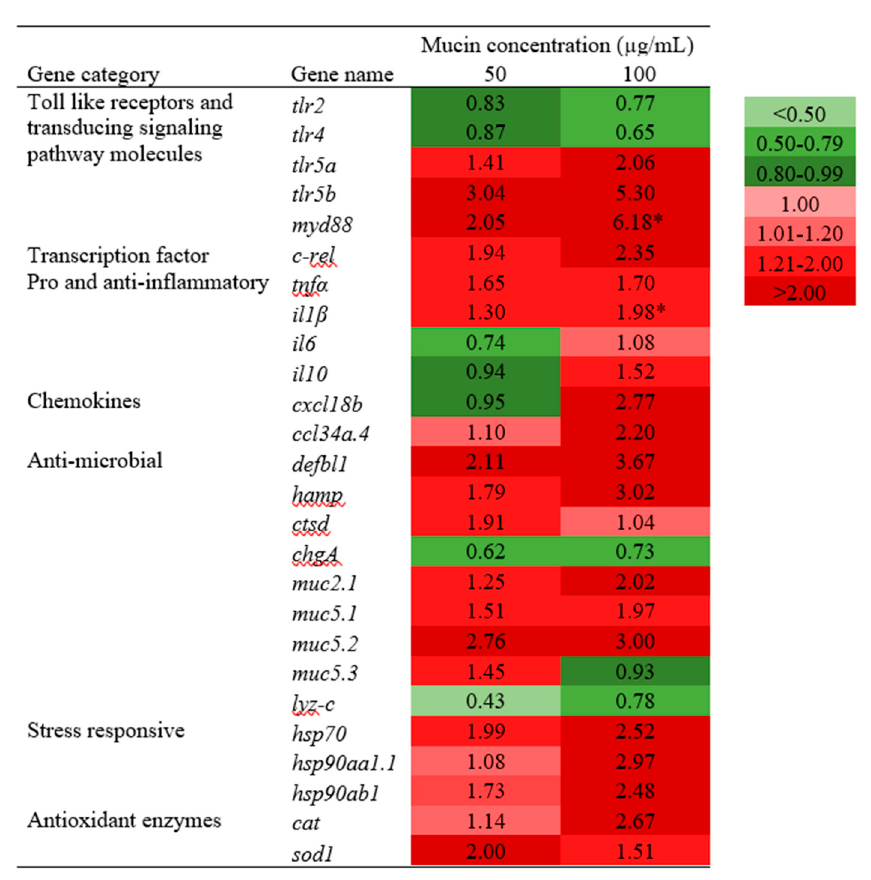
Figure 5. The relative mRNA expression of immune and antioxidant genes in PGM-exposed zebrafish larvae. Embryos (2 days post fertilization (dpf)) were exposed to PGM (0, 50, and 100 µg/mL), and larvae were sampled at 7 dpe for isolating RNA. The asterisk marks are used to indicate the statistical significance compared to the control. Basal expression level was considered as 1.00-fold; upregulated and downregulated expressions were considered as >1.01-fold and <0.80-fold, respectively (one-way ANOVA, * p < 0.05).